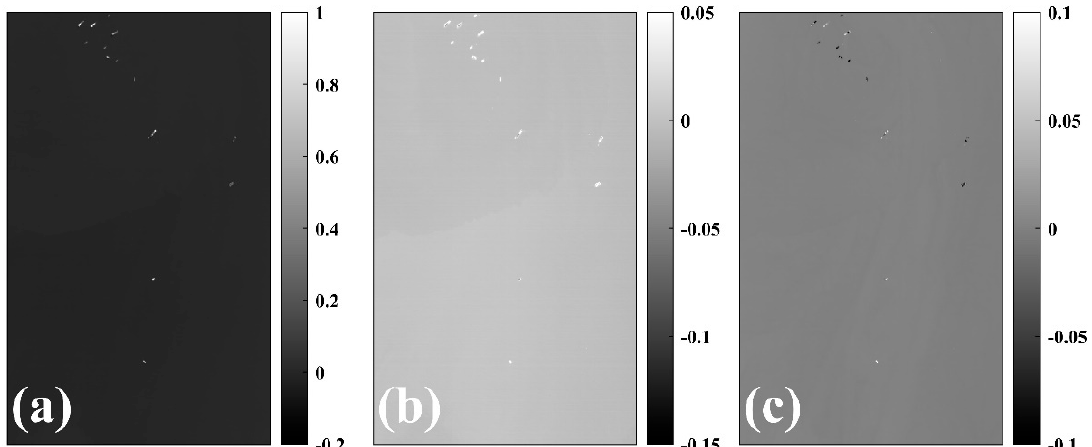
Figure 5. Spatial distributions of ( a ) the first mode, ( b ) the second mode, and ( c ) the third mode of the airborne hyperspectral data from principal component analysis (PCA).